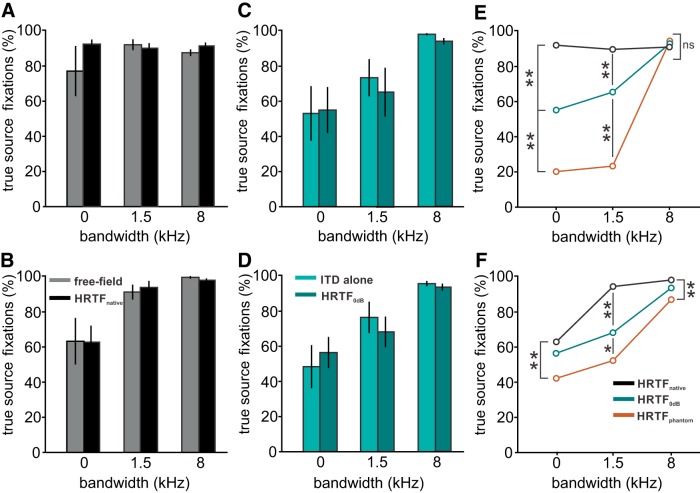
Experiment 2. Behavioral experiments with HRTF-filtered stimuli. Upper row, data from owl 1. Lower row, data from owl 2. The plots show the average percentage of turns toward the true source across all stimulus directions in response to noise with different bandwidth (1.5 kHz, 8 kHz) and tones (0 kHz). A, B, Comparison between free-field experiments (gray) and experiments with native HRTFs (black). C, D, Earphone stimuli with flat spectra and ILD = 0 dB (ITD alone, light-cyan) and HRTF with ILD fixed to 0 dB (HRTF0dB, dark cyan). E, F, HRTF-filtered stimuli with the ILD fixed to the value measured at the direction of the phantom sound source. Error bars show SEM over six stimulus locations used in this study (±52.5°/±150 µs, ±35°/±100 µs, and ±17.5°/±50 µs); **p < 0.01, *p < 0.05 with Pearson’s χ2 test; ns, not significant.